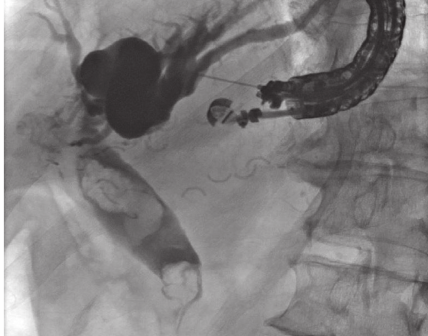
Figure 3: EUS-guided cholangiography showing a dilated biliary tree with choledocholithiasis.